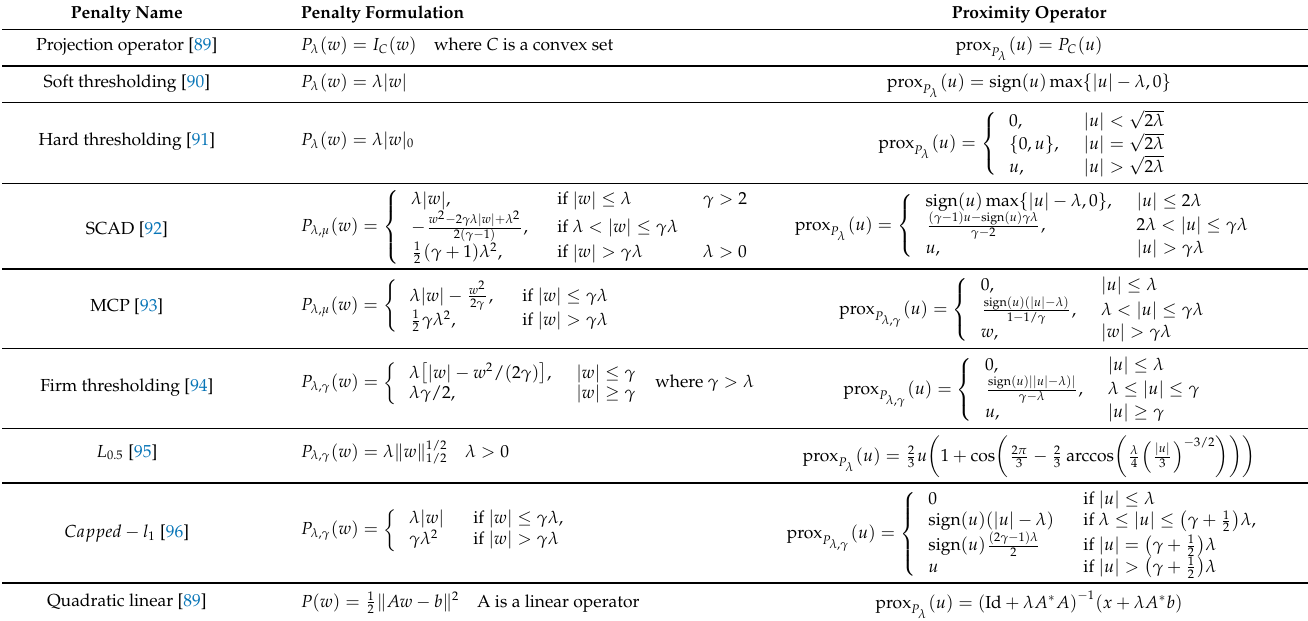
Table 6. Regularization penalties and the corresponding proximity